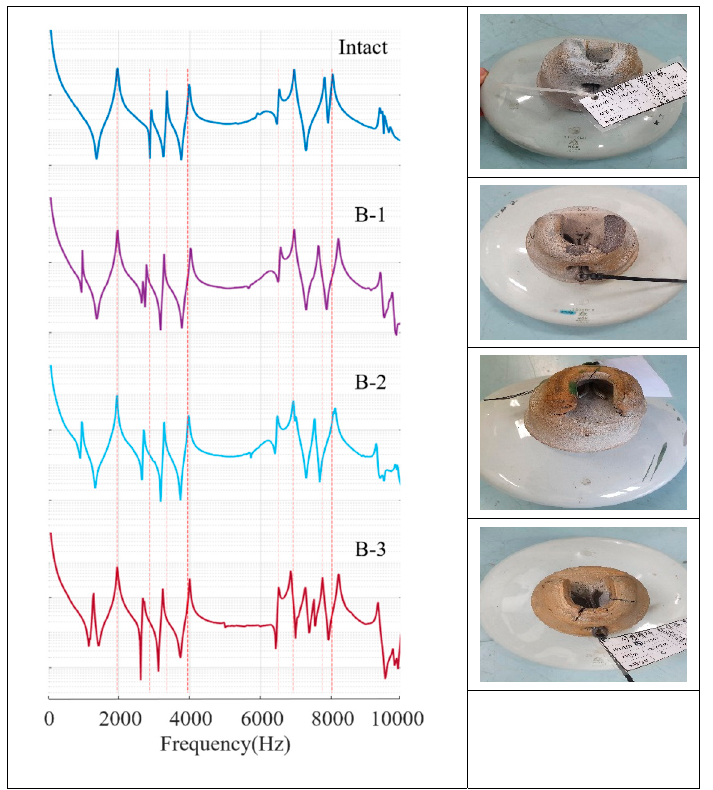
Figure 7. Cap defective samples and FRF results.